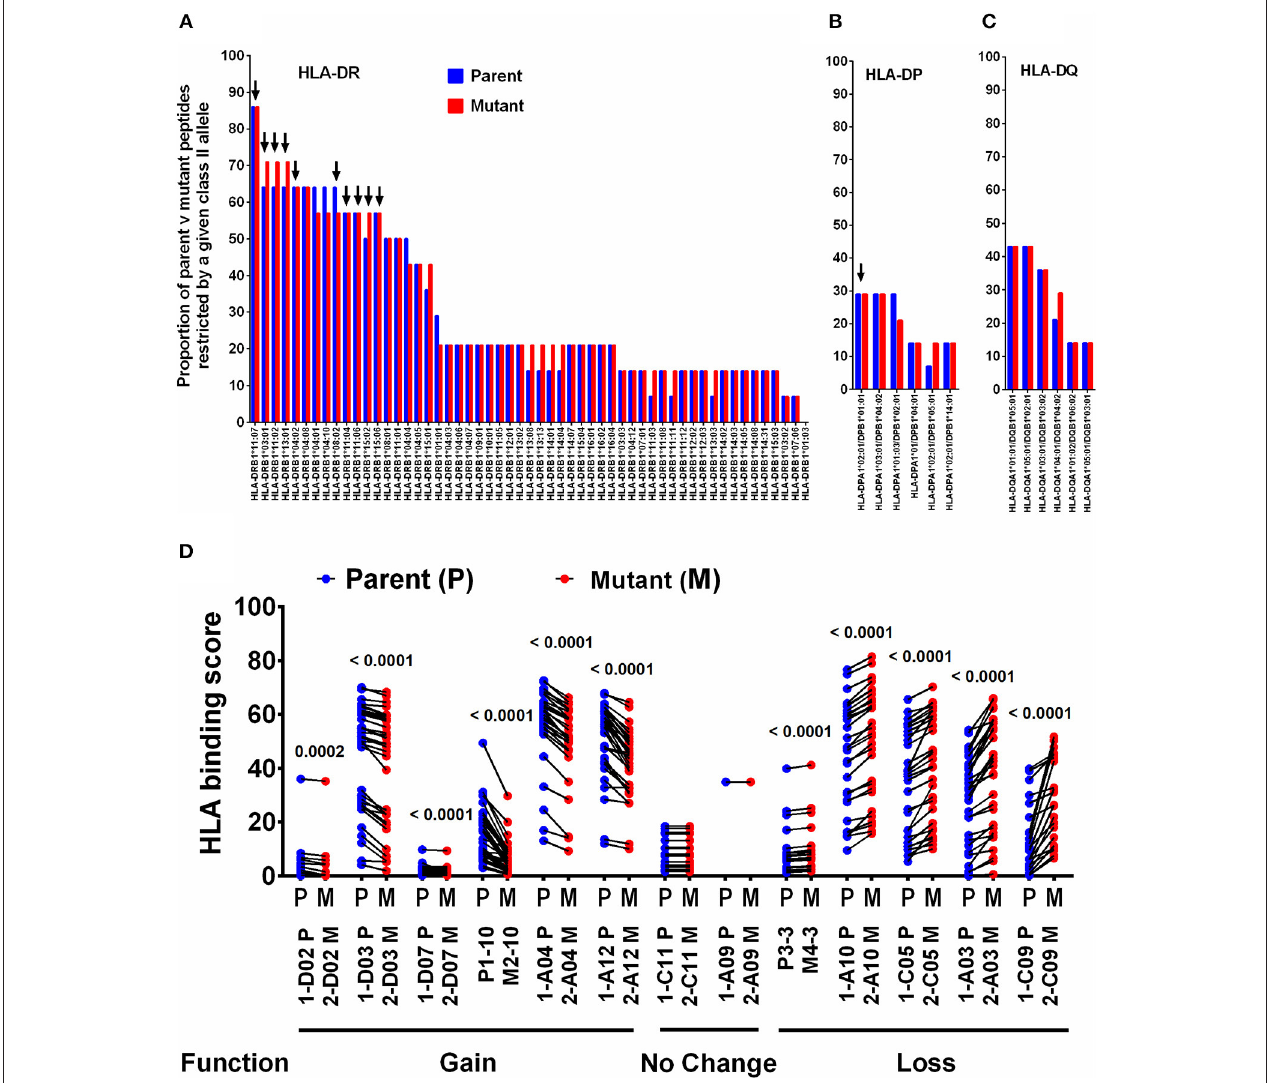
FIGURE 5 | Binding of T-cell epitopes to Indian HLA-DR/DP/DQ alleles. (A) Proportion of a 20 mutant TCEs (15 mer; red) and their corresponding parent/reference TCEs (blue) restricted by 55 HLA-DR alleles identified in the Indian population. Only epitopes with binding affinity score IC ≤ 10nM were considered. (B) Binding to DP alleles and, (C) Binding to DQ alleles. (D) Binding affinity of 13 selected 15 mer parent and mutant peptides to DR alleles, which predict gain or loss or no change in function–see Figure S6 for corresponding IFN γ release